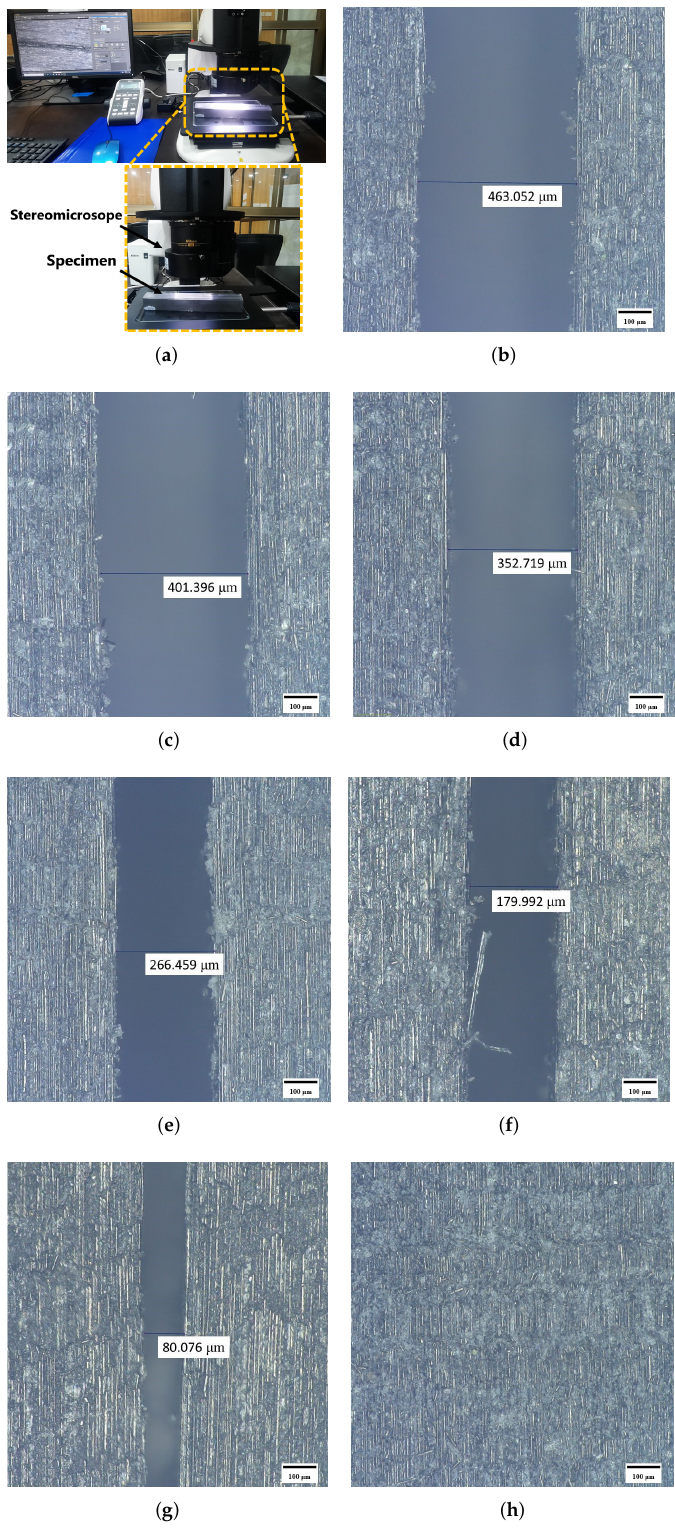
Figure 4. Stereo micrographs depicting the void reduction in the laminates under high pressure. ( a ) Setup for stereo microscopy. ( b ) A void of 463.052 µ m was observed at 1 bar pressure. ( c ) A void of 401.396 µ m was observed at 2 bar pressure. ( d ) A void of 352.719 µ m was observed at 3 bar pressure. ( e ) A void of 266.459 µ m was observed at 4 bar pressure. ( f ) A void of 179.992 µ m was observed at 5 bar pressure. ( g ) A void of 80.076 µ m was observed at 6 bar pressure. ( h ) No significant voids were observed at 7 bar